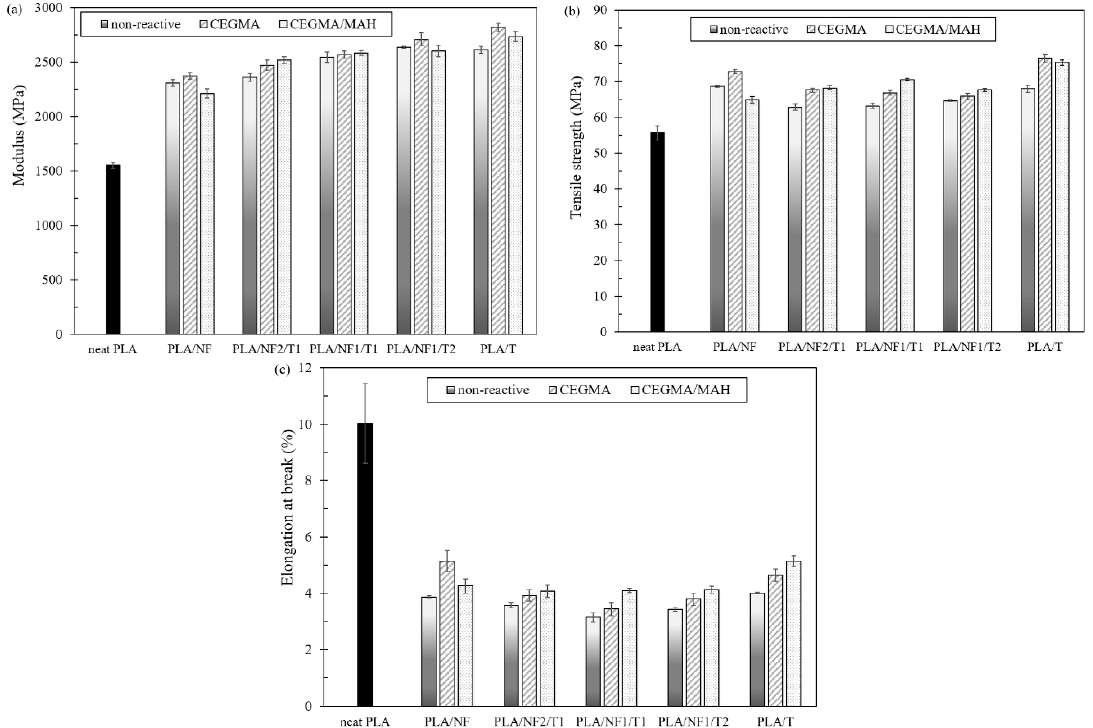
Figure 2. ( a ) Modulus; ( b ) tensile strength and ( c ) elongation at break of PLA hybrid composites at different fillers ratios, with and without various reactive compatibilizers.